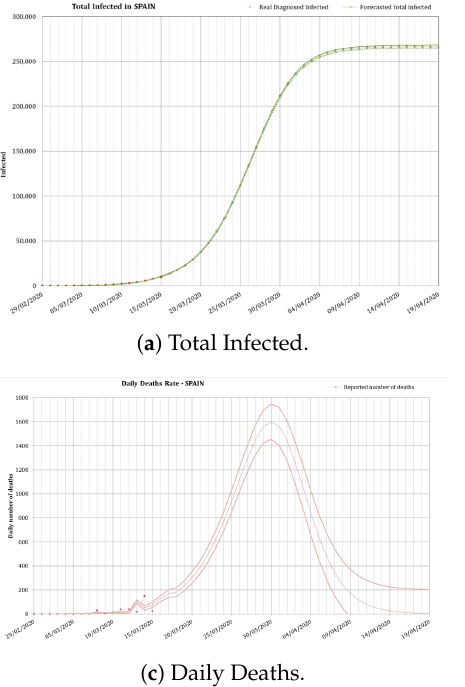
Figure 6. Total number of infected (a) , total deaths (b) and daily deaths (c) in Spain predicted from 29 February/19 April. The preliminary results assumed the total lock-down since the 15 March with data up to the 14 March. Red dots—reported data. Green bars—modelled values with